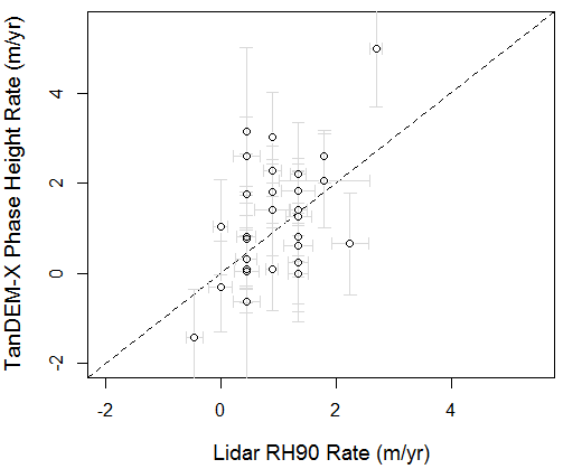
Figure 6. TanDEM-X phase-height rates, evaluated over August 2012–August 2013 period versus RH90 rates estimated by lidar (red rectangles in Figure 1) over the same time period. The dashed line is y = x